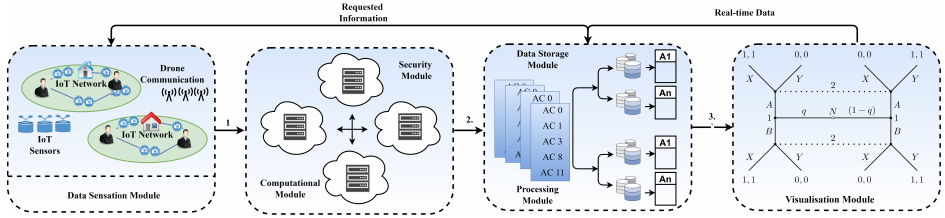
Figure 2. Proposed modular framework: conceptual